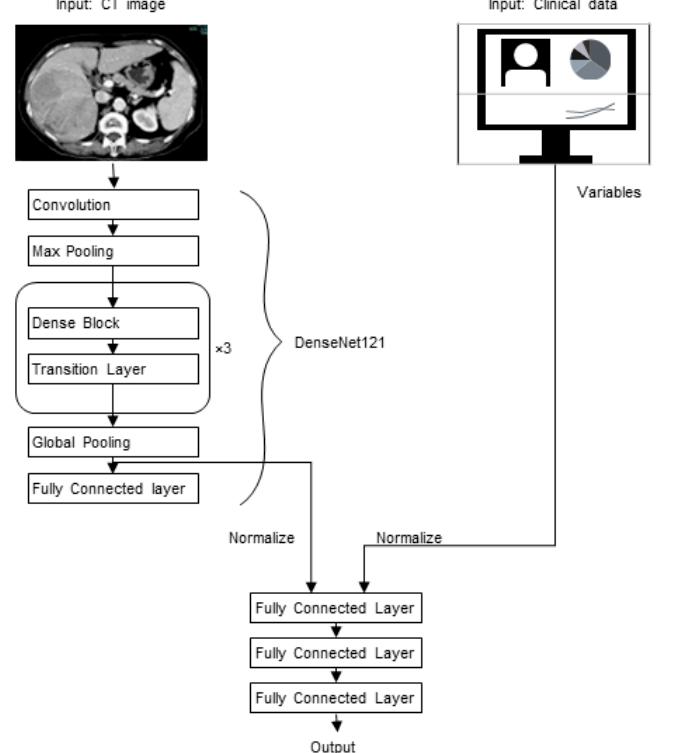
Figure 2. Outline of the mixed artificial intelligence model. In this model, we used one variable from convolutional neural network (CNN) output and 6 variables from clinical data. The output of CNN and clinical data were used as input for multiple perceptrons (MLP), and the output of MLP was arranged to show recurrence or not. Our trials evaluated InceptionV3, ResNet50, and DenseNet121 as feature extractors. DenseNet121 achieved the highest performance in the model, which is discussed here. First, the CT images were fed into the feature extractor that was composed of convolutional layers, wherein the images were downsampled by half each pass through the convolutional layers. The feature extractor results were connected to a classifier, in which the affine was followed by a sigmoid activation function and a binary cross-entropy loss function. This process was repeated many times with the training data to optimize parameters for a model that can determine patient prognosis when developing the model. DenseNet121 consists of five parts, including convolutional layer1 and Dense block1, 2, 3, and 4. Convolutional layer1 consists of one 7 × 7 convolutional layer. Each Dense block consists of one 1 × 1 and two 3 × 3 convolutional layers. Block1 is repeated 6 times, block2 is repeated 12 times, block3 is repeated 24 times, and block4 is repeated 16 times. A 1 × 1 convolutional layer and one max-pooling layer, collectively called the transition layer, is present at the transition between blocks 1 and 2, blocks 2 and 3, and blocks 3 and 4. FC, fully connected layer.